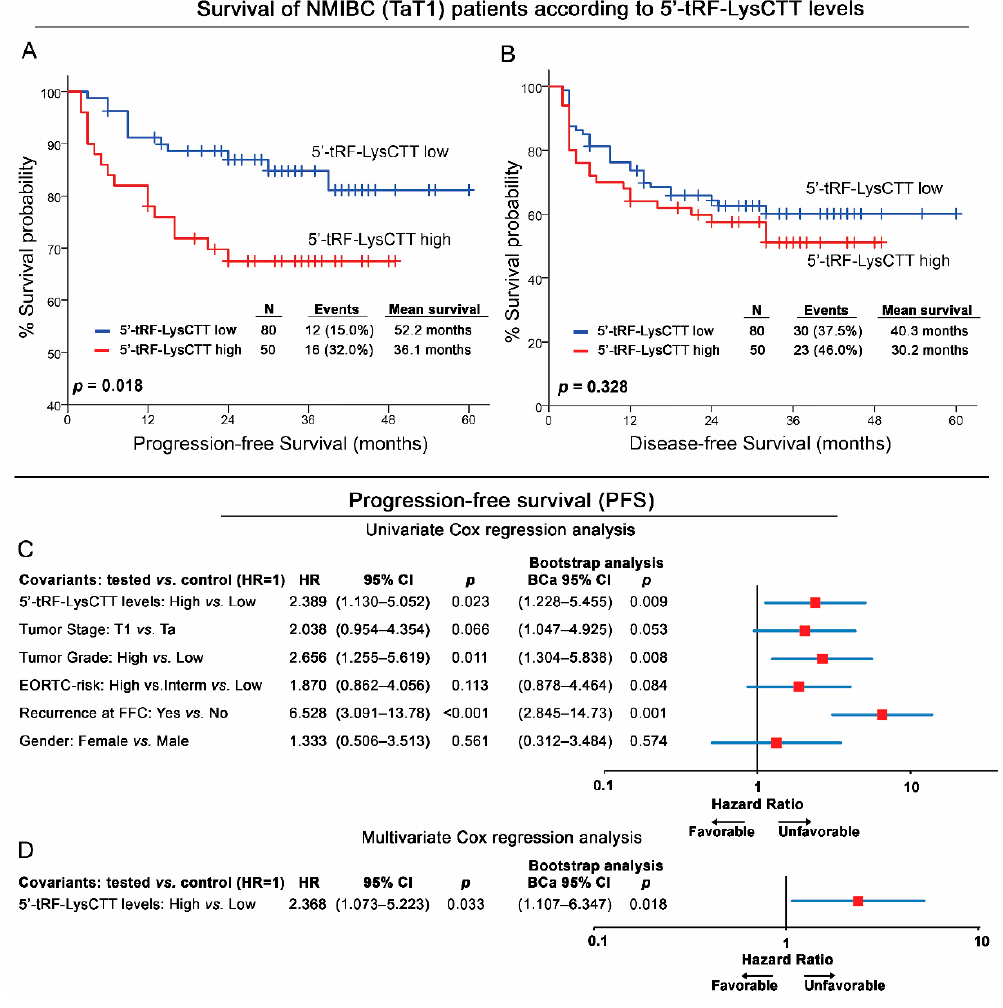
muscle-invasive (MIBC) bladder cancer ( B ), tumor stage ( C ) and tumor grade ( D ) in the screening cohort ( n = 230). p -values calculated by Mann–Whitney U test ( B , D ) and Kruskal–Wallis test ( C ). ( E – G ) Box plots presenting the correlation of 5 ′ -tRF-LysCTT levels with tumor stage and grade ( E ), EORTC risk-group ( F ) and recurrence at first follow-up cystoscopy (RFFC) in the screening NMIBC